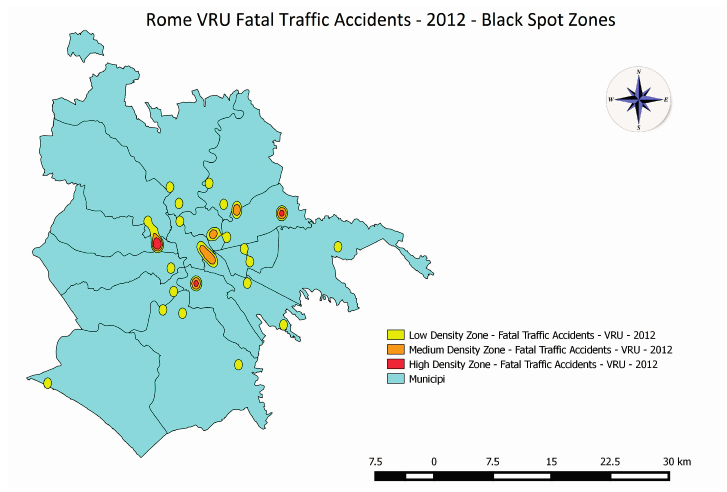
Figure 8. Black spot zones. Fatal traffic accidents involving VRU in Rome in